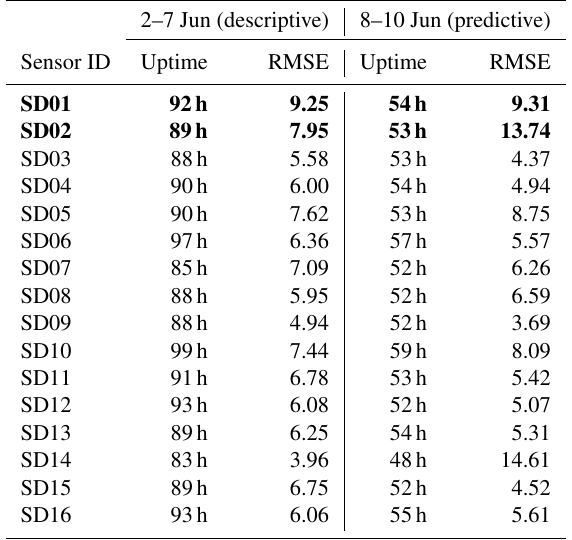
Table 4. Descriptive and short-term predictive error of model D in µgm − 3 .